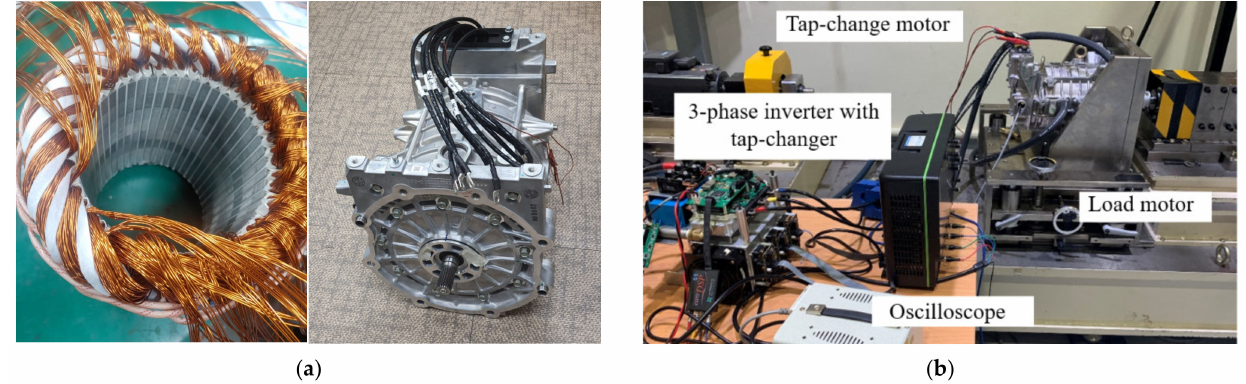
Figure 9. ( a ) Rewiring of the tap-change motor and ( b ) experimental